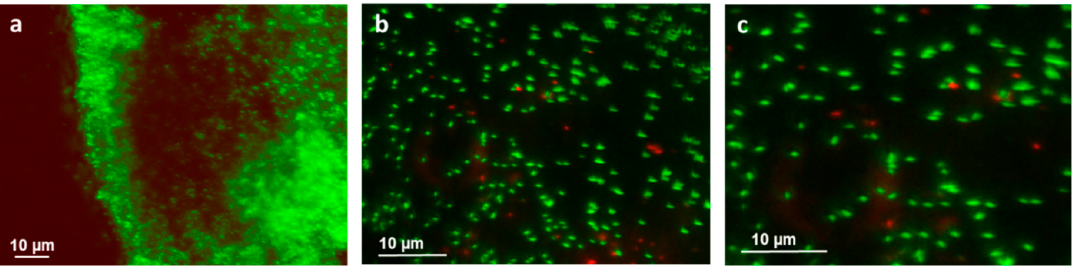
Figure 6. Fluorescence microscopy images of S. aureus on the surfaces of Nylon 6 ( a ); Nylon 6-NH ( b ) and Nylon 6-N-PEG ( c ).